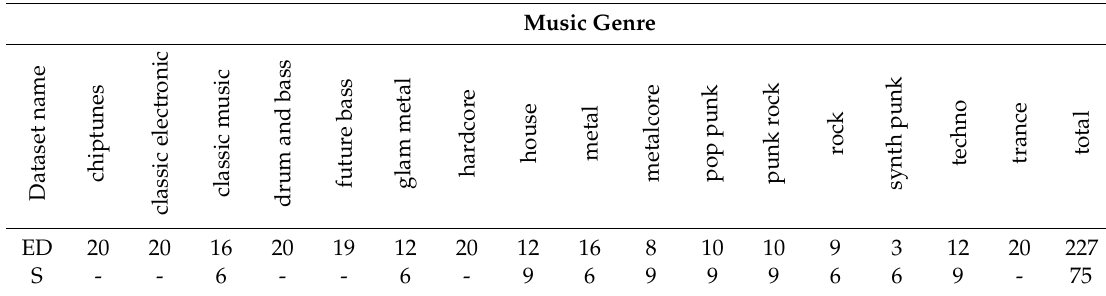
Table 3. Number of musical excerpts in each dataset together with the genre composition of ED and S datasets. Genres that are not present in the S dataset are marked with the hyphen.